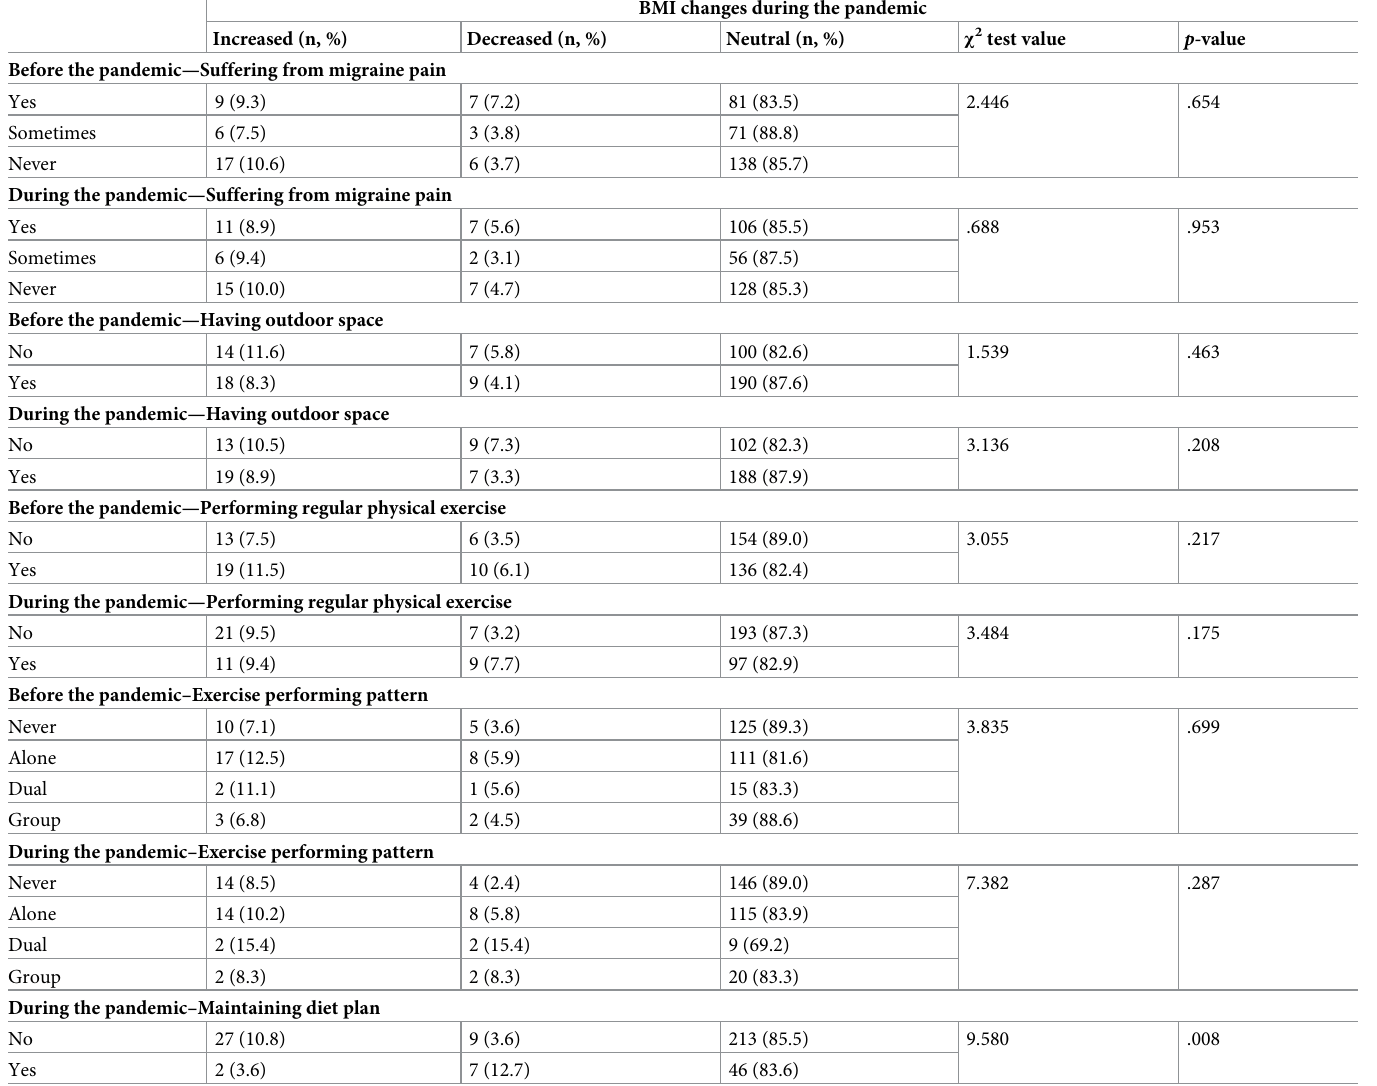
Table 4. Associations between physical activities -related variables and BMI